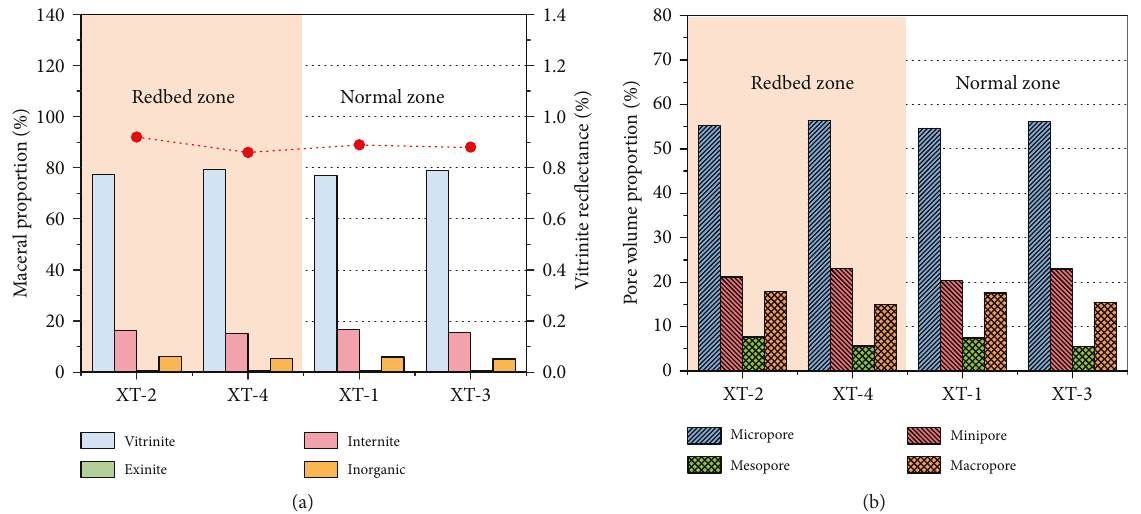
Figure 6: Petrographic (a) and pore structure (b) analyses of coal seam samples in the Xutuan coal mine. 0.0010